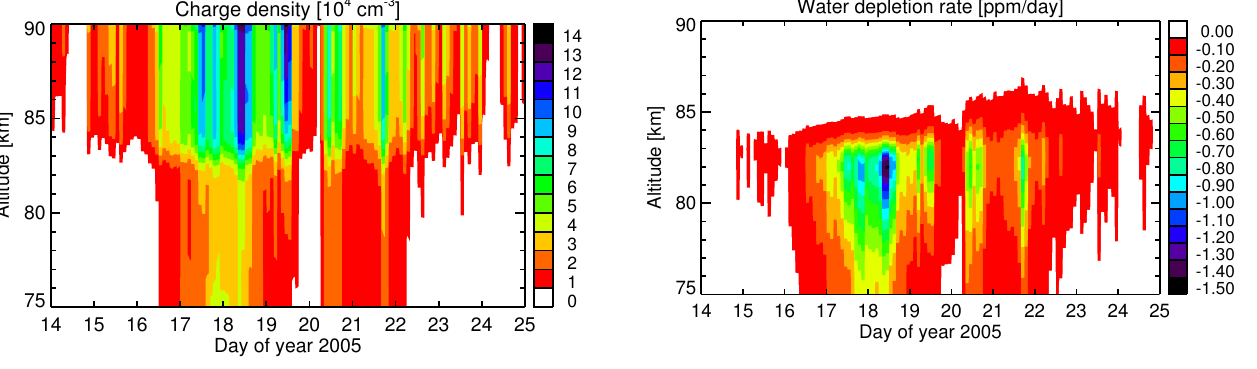
Fig. 13. The modelled rate of water depletion at 75 ◦ S in units of ppm per day due to ion chemistry.